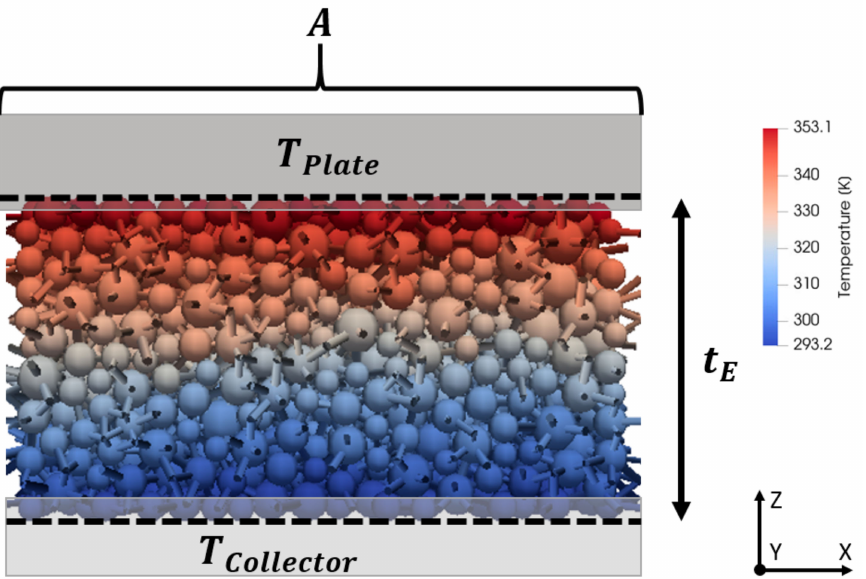
Figure 1. Example for a simulated model electrode. Bonds are displayed as cylinders between the spherical particles. Temperature of the respective particle or bond is represented by color. The position of the plates representing the roll ( top ) and the current collector ( bottom ) relative to the electrode is depicted in grey. The dashed lines represent the upper and lower surface of the